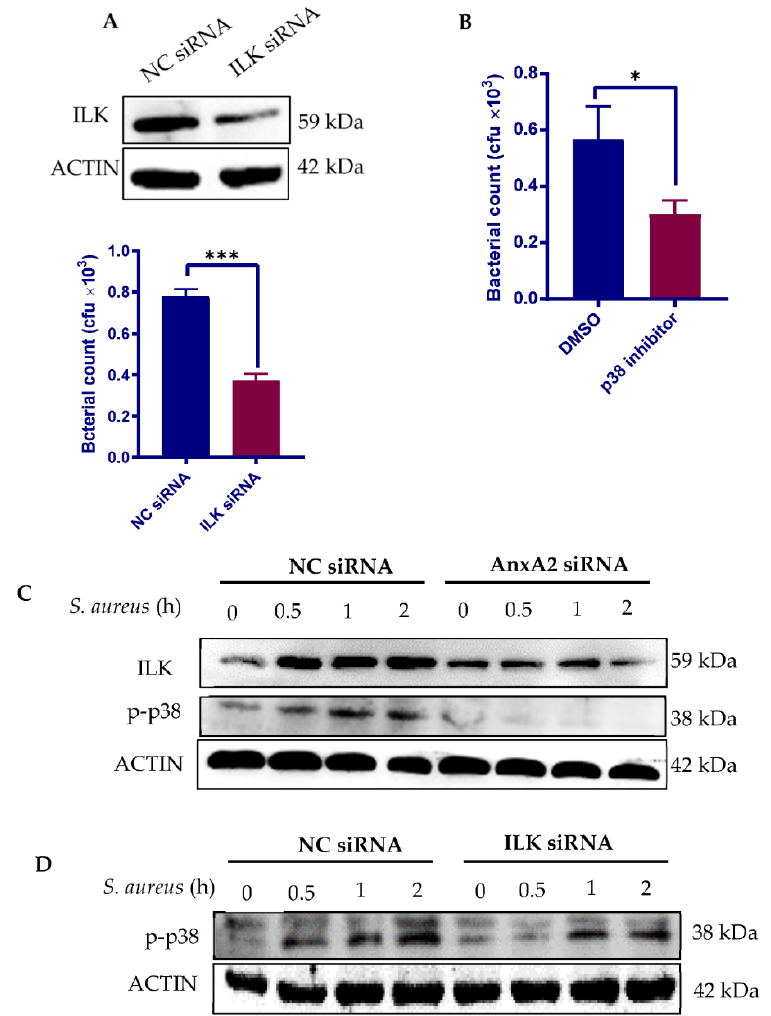
Figure 3. AnxA2 engagement activates ILK/p38 MAPK pathway. (A) Evaluation of the effect of ILK on S. aureus internalization by MAC-T. MAC-T cells were treated with either NC siRNA or ILK siRNA for 72 h. Whole-cell extracts were analyzed by immunoblotting with anti-ILK (upper panel). β -actin is shown as a loading control. The ILK-deficient cells were then co-cultured with clinical isolate of S. aureus (Clin-SA) at an MOI of 50 for 1 h. Bacterial invasion was determined by gentamicin protection assays (lower panel). The graph shows mean values ± s.d. of three replicates. ( B ) Evaluation of the effect of p38 MAPK on S. aureus internalization by MAC-T. MAC-T cells were pre-treated with SB203580, a selective inhibitor of p38 MAPK, at 10 µ M for 2 h and infected with Clin-SA at an MOI of 50 for 1 h. Bacterial invasion was determined by gentamicin protection assays. The graph shows mean values ± s.d. of three replicates. ( C ) Evaluation of the effect of AnxA2 engagement on ILK expression and p38 MAPK phosphorylation. MAC-T cells were treated with either NC siRNA or AnxA2 siRNA for 72 h and then subjected to Clin-SA infection at a MOI of 25 for 2 h. Whole-cell extracts were analyzed by immunoblotting with antibodies against AnxA2, ILK and phosphorylated p38 MAPK. β -actin is shown as a loading control. ( D ) Evaluation of the effect of ILK engagement on p38 MAPK phosphorylation. MAC-T cells were treated with siRNA and Clin-SA as described in ( A ). Whole-cell extracts were analyzed by immunoblotting with antibodies against ILK and phosphorylated p38 MAPK. β -actin is shown as a loading control. * P < 0.05; *** P < 0.001.